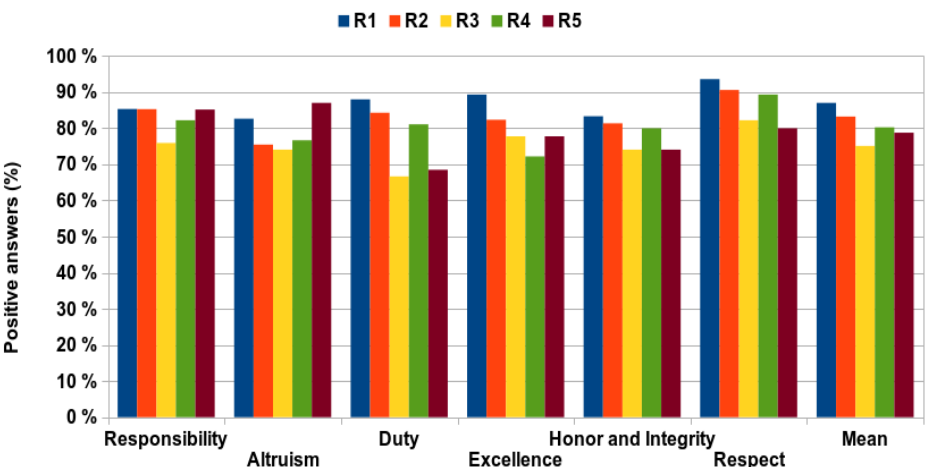
Figure 2. Mean percentage of professionalism categories in every year of residence.